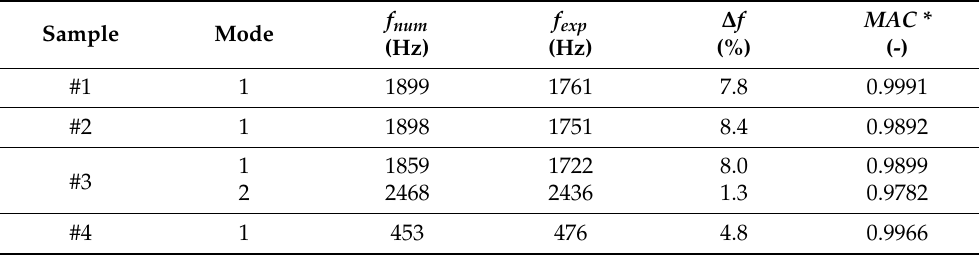
Table 2. Natural frequencies obtained numerically and experimentally for samples #1–4.